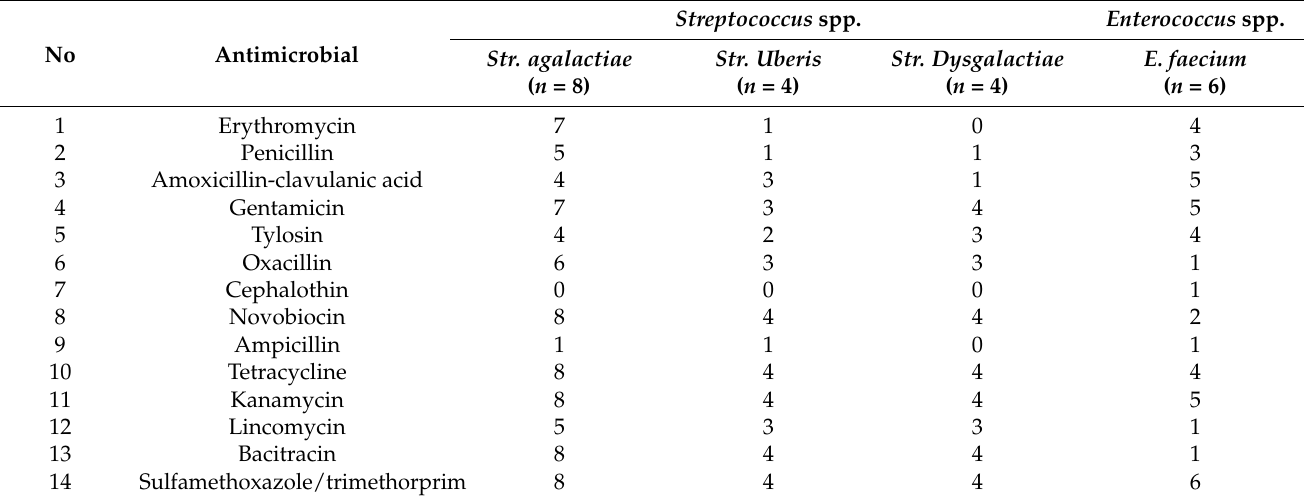
Table 3. Antimicrobial drug resistance profile of the isolated streptococci and enterococci strains. Streptococcus spp. Enterococcus spp. No Antimicrobial